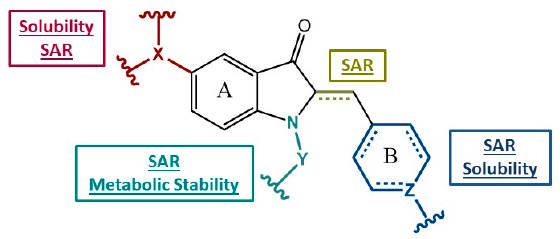
Figure 1. Derivatization of the azaaurone scaffold, with main objectives per Figure 19. Derivatization of the azaaurone scaffold, with main objectives per moiety. Funding